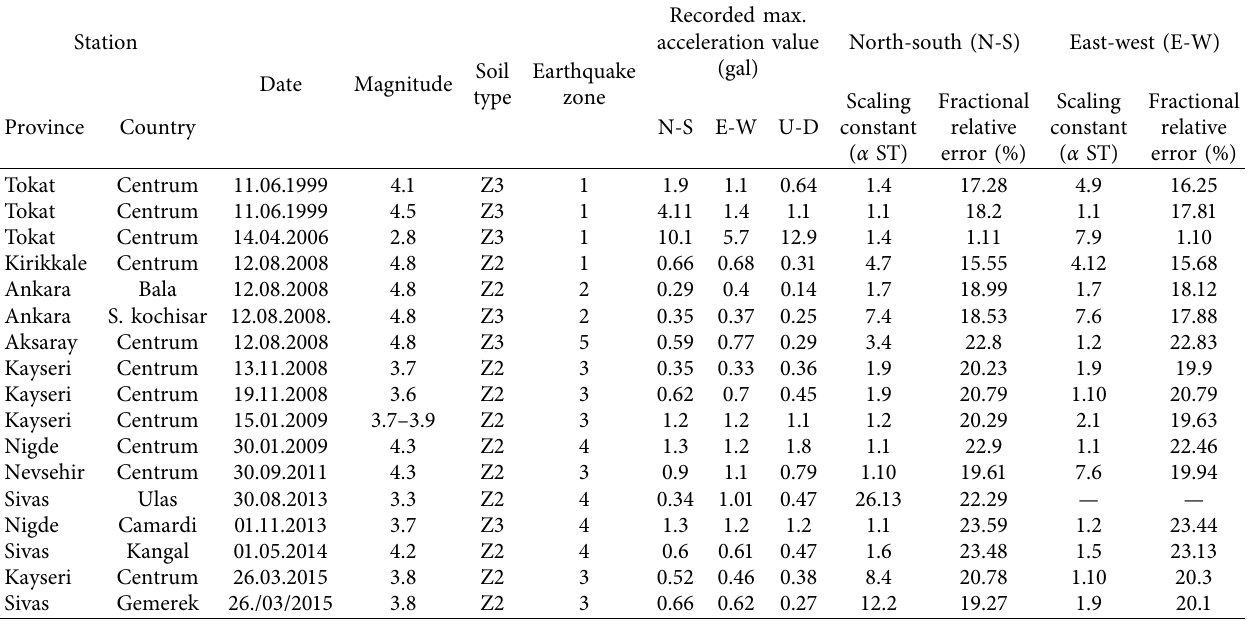
Table 1: Details and calculated scaling constant ( α ST ) of records of earthquakes that occurred throughout the Central Anatolian Fault Zone (CAFZ), Turkey.